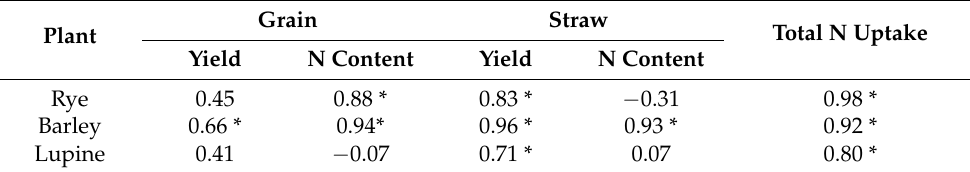
Table 6. Correlation coefficient between cumulative soil respiration and crop yields of grain and straw, content of total nitrogen in grain and straw, nitrogen uptake by